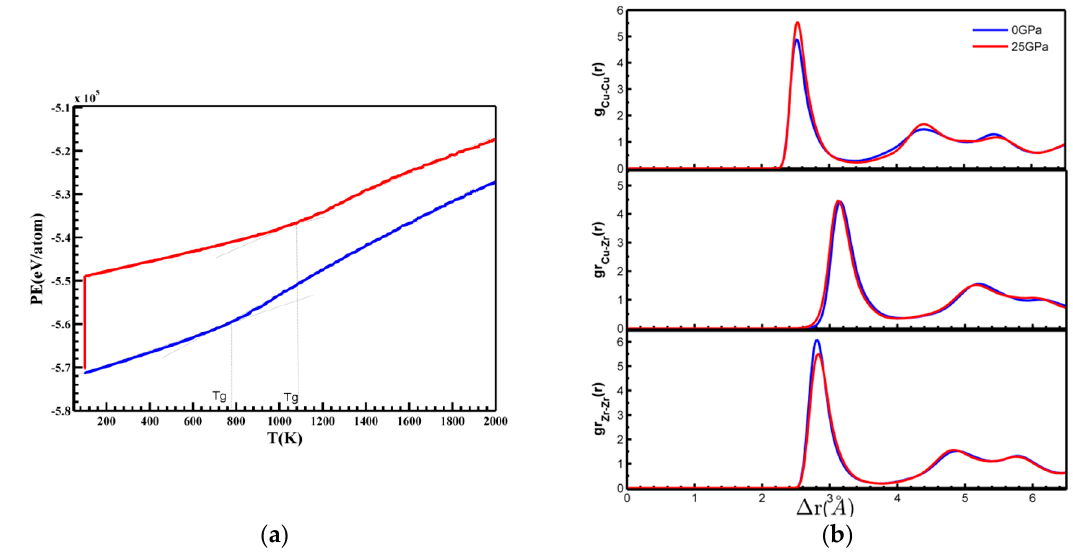
Figure 3. ( a ) Total energy of the two samples with applied pressures of P = 0 and 25 GPa at T = 100 K; ( b ) The pair correlation function (PCF) of the two samples with applied pressures of P = 0 and 25 GPa at T = 100 K.